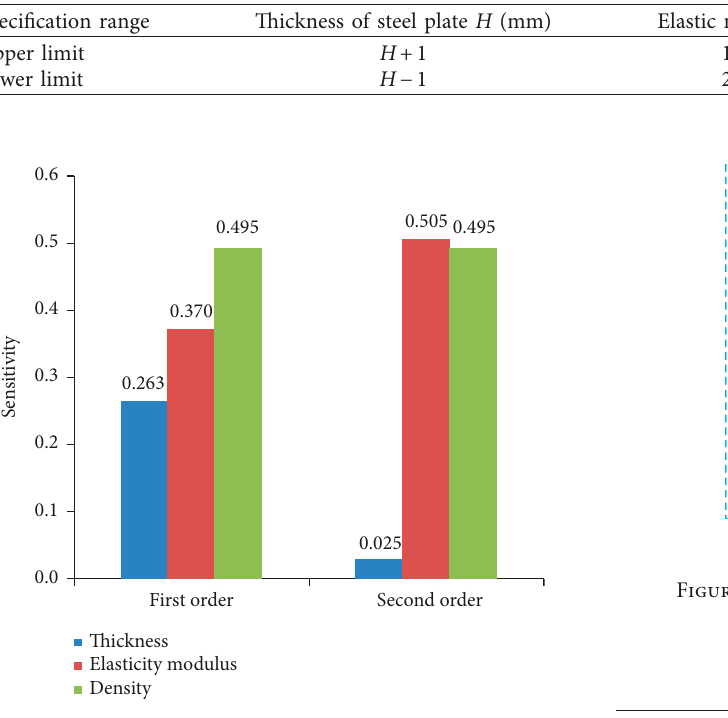
Figure 6: Sensitivity analysis of candidate parameters.